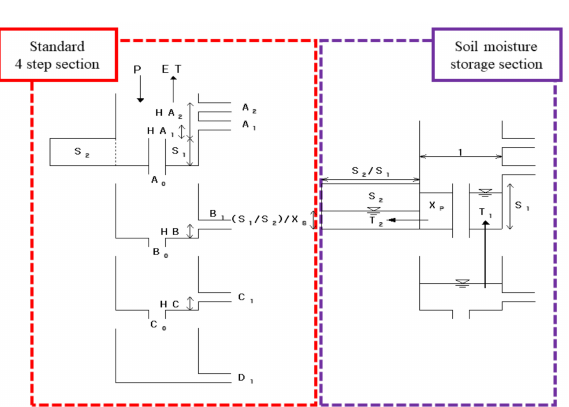
Figure 3. Outline of soil moisture storage tank model. A 2 : 1st tank upper runo ff mode coe ffi cient, A 1